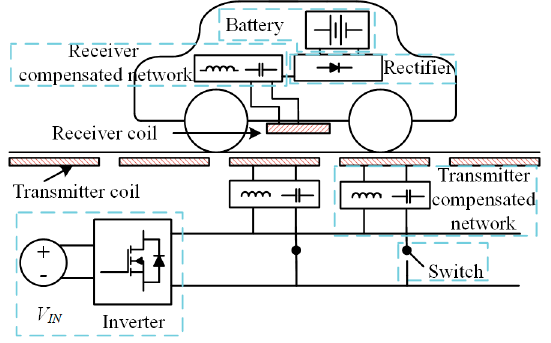
Figure 1. The structure of a short − segmented DWPT system.